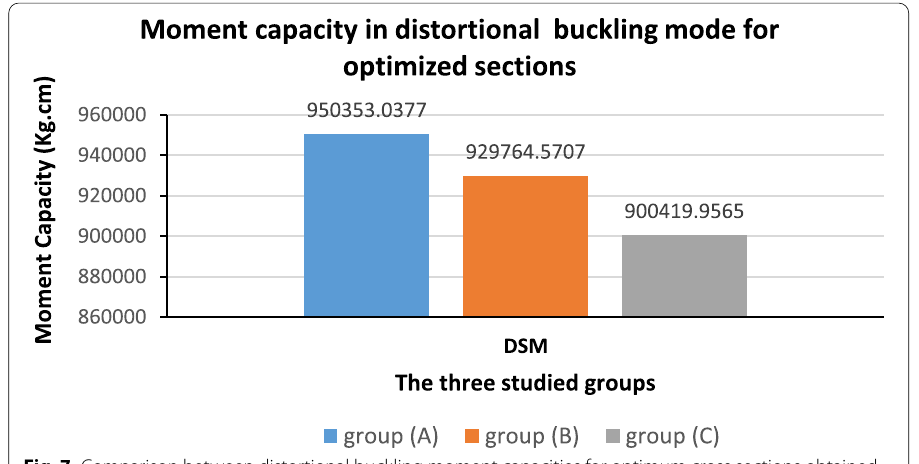
Fig. 7 Comparison between distortional buckling moment capacities for optimum cross sections obtained from PSO using